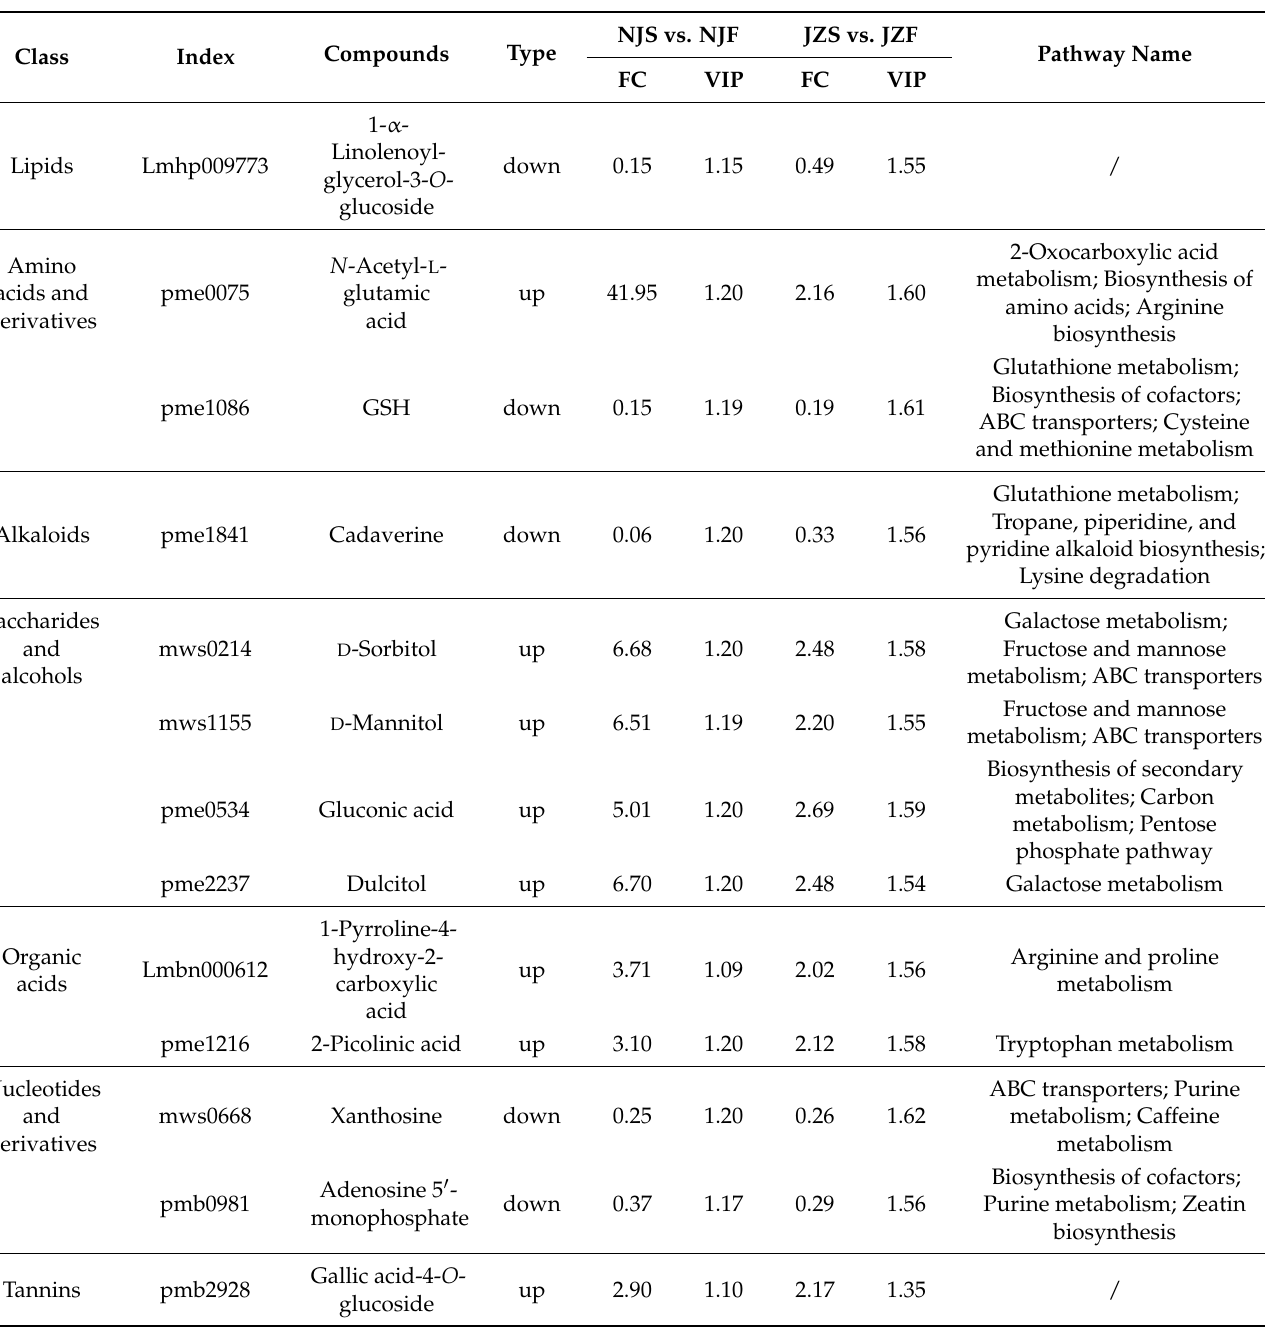
Table 2. Common differential metabolites of two